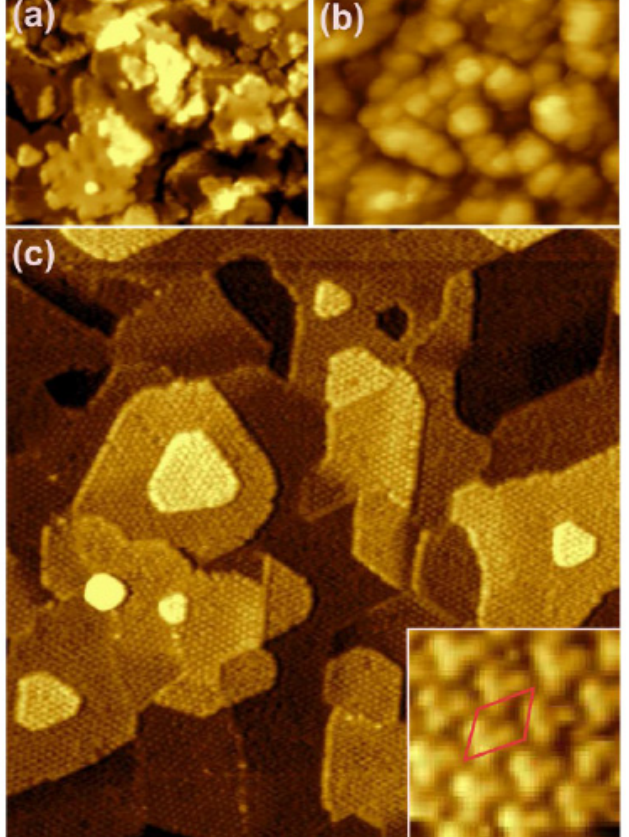
Figure 7. STM images showing the different stages of formation of c-Ce 2 O 3 films on Cu(111). ( a ) CeO 2 buffer, ( b ) CeO 2 buffer with subsequent metallic Ce deposition, ( c ) ordered c-Ce 2 O 3 layer obtained by annealing (b) in vacuum at 900 K. Inset: High-resolution image and surface unit cell (red rhombus) of the c-Ce 2 O 3 layer. Images a–c are to scale. Image width ( a , b ) 60 nm, ( c ) 120 nm, (inset) 6 × 6 nm 2 . Reprinted with permission from